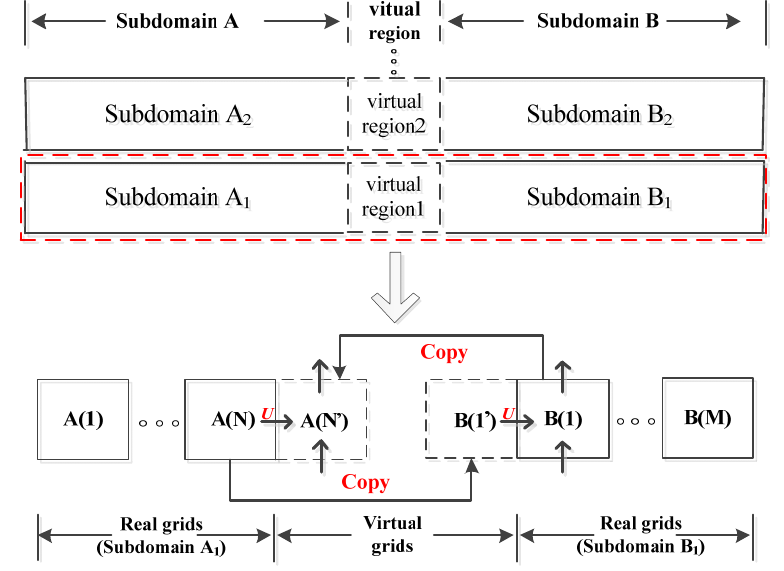
Figure 3. Domain decomposition and variable assignment of virtual grids.